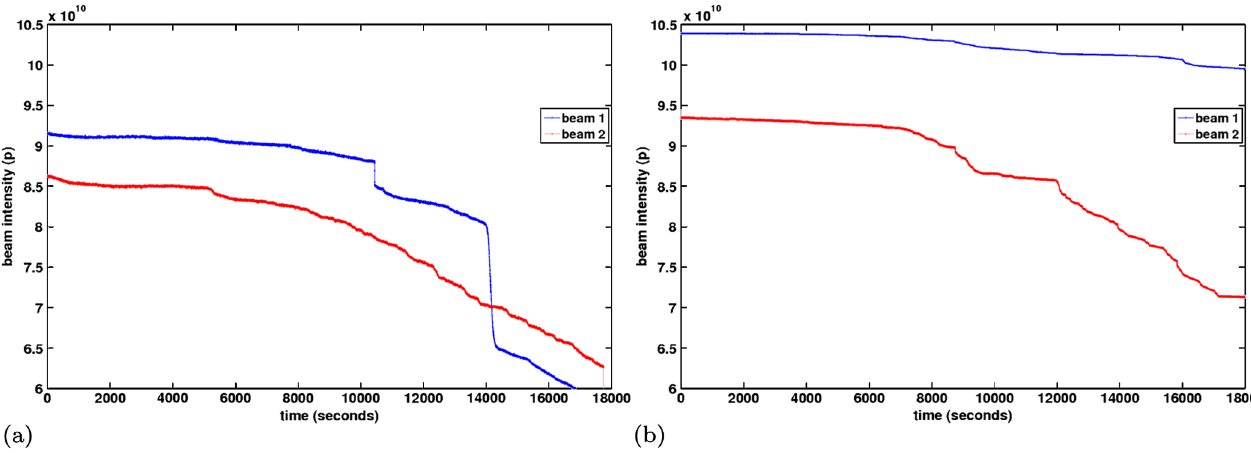
FIG. 10. Examples of the variation of beam intensity during manual (a) and semiautomatic (b) setup at 3.5 TeV. T(0) for manual setup corresponds to 13.06.2010 07:30:00, while T(0) for semiautomatic setup corresponds to 07.03.2011